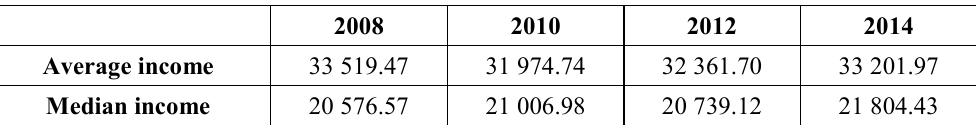
Table 3. Household Income in $MXP,